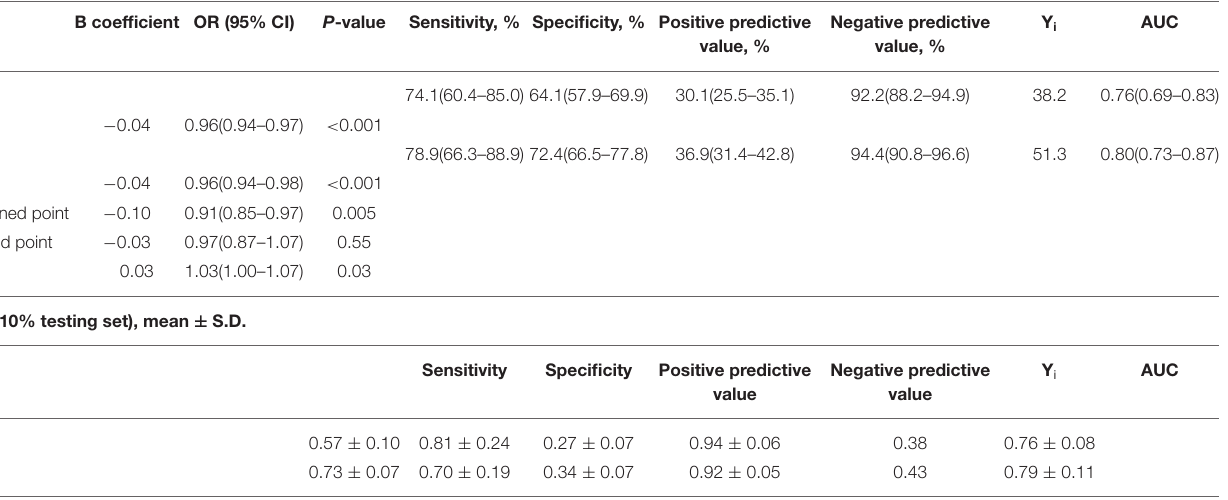
TABLE 2 | Explaining dependency in activities of daily living 3 months after stroke.